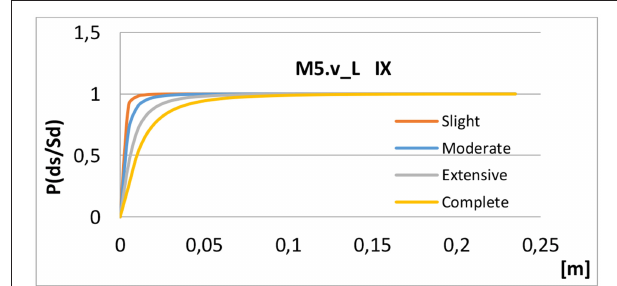
FIGURE 11 | Fragility Curve for the earthquake intensity